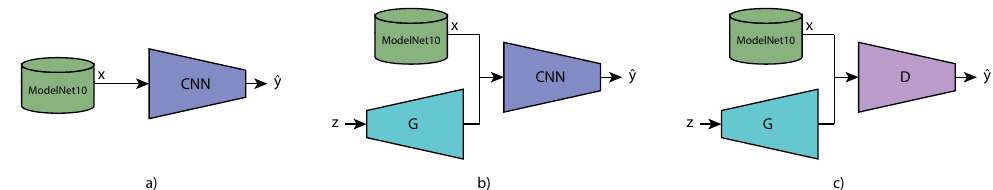
Figure 2. High-level architecture of the tree models designed for the proposed experiment. The first model ( a ) is a plain 3D convolutional (CNN) classifier trained directly on ModelNet10. The other CNN ( b ) is trained on an augmented dataset created by combining ModelNet10 examples and the conditional generator ( G ) output. The generator output is labeled according to its input condition vector. The last model ( c ) is a three-dimensional (3D) conditional Generative Adversarial Network (GAN) network where the discriminator ( D ) is used as the classifier during the testing